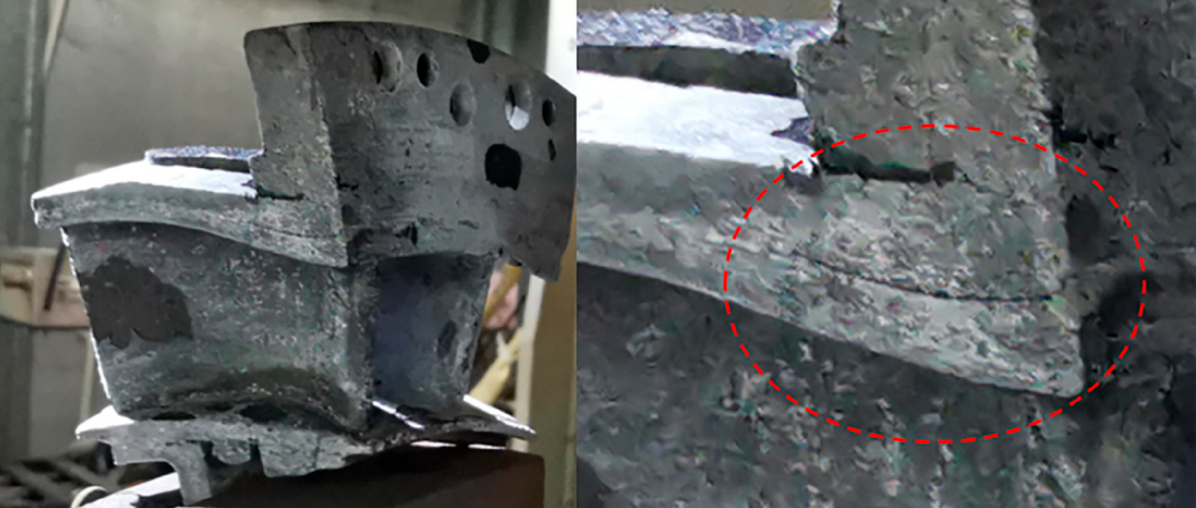
Figure 11. Thermal shock test of SiC/SiC twin guide vane at target temperature of T = 1450 °C at N = 300.